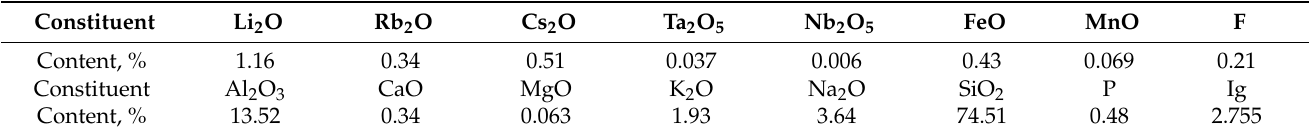
Table 3. Results of chemical multi-element